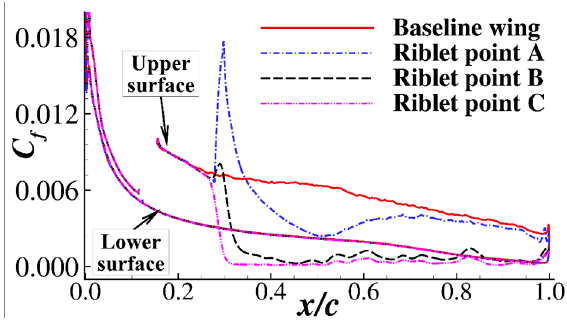
Figure 11. Averaged pressure coefficients of the smooth and riblet-covered wing with and without a sweep angle.